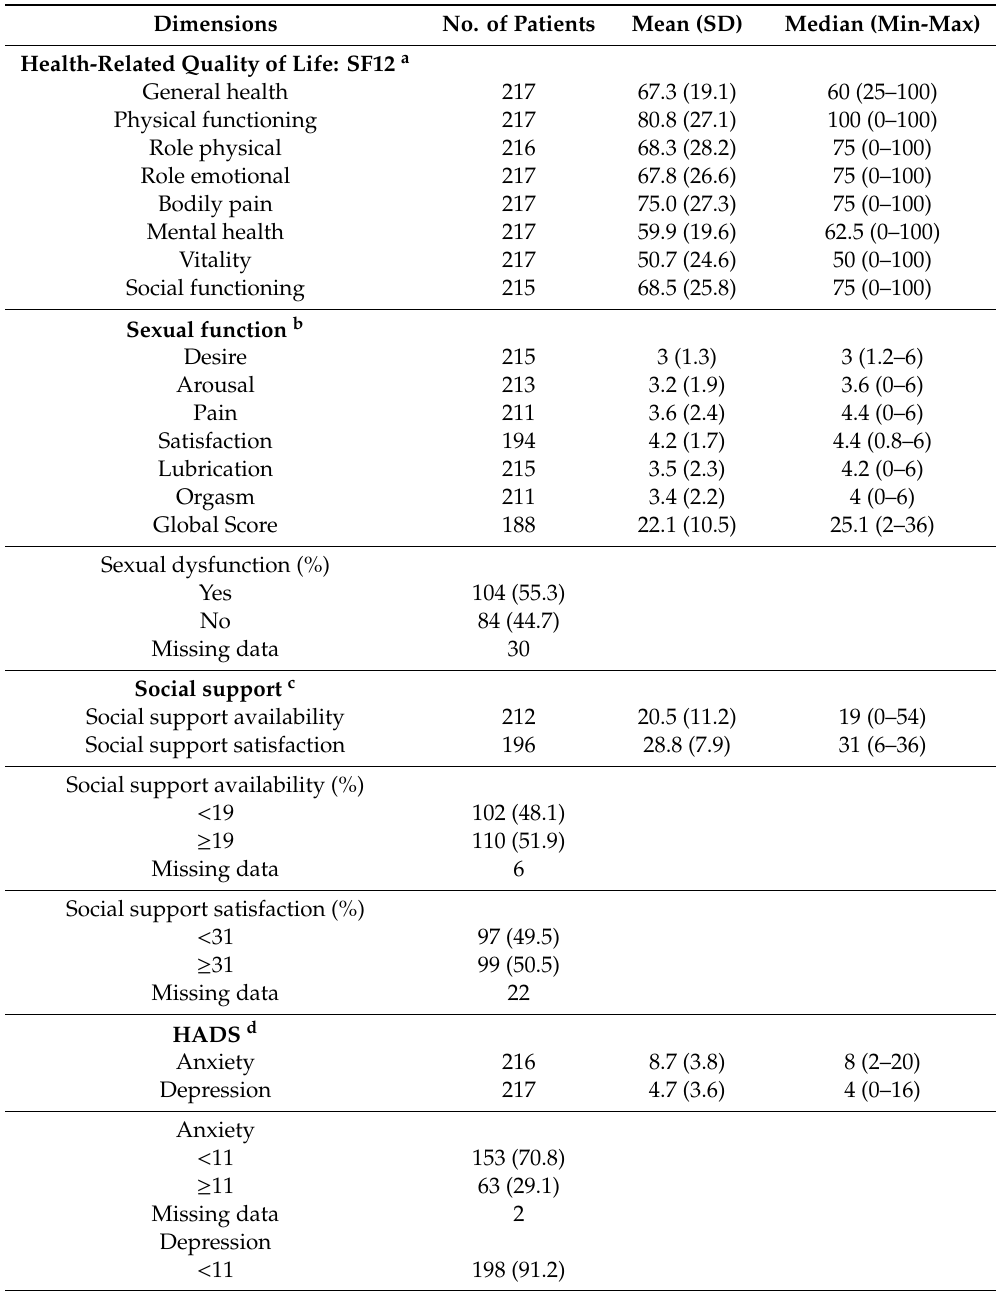
Table 2. Health-related quality of life (HRQoL), sexual function, social support, anxiety and depression scores in the study population (N =